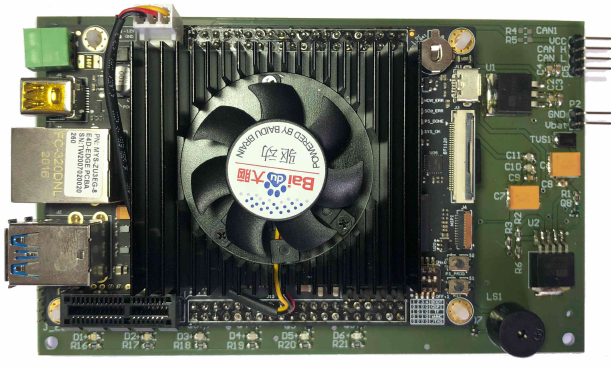
Figure 3. IASE hardware and FZ3 card top